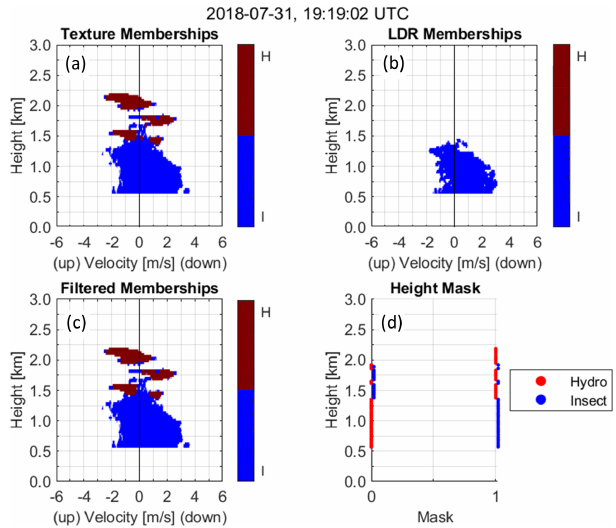
Figure 8. Spectral memberships and binary mask for profile at 19:19:02UTC on 31 July 2018. The red color indicates hydrom- eteor membership and the blue color represents insect membership. (a) Texture algorithm spectral membership. (b) LDR algorithm spectral membership. (c) Filtered spectral membership. (d) Binary hydrometeor and insect